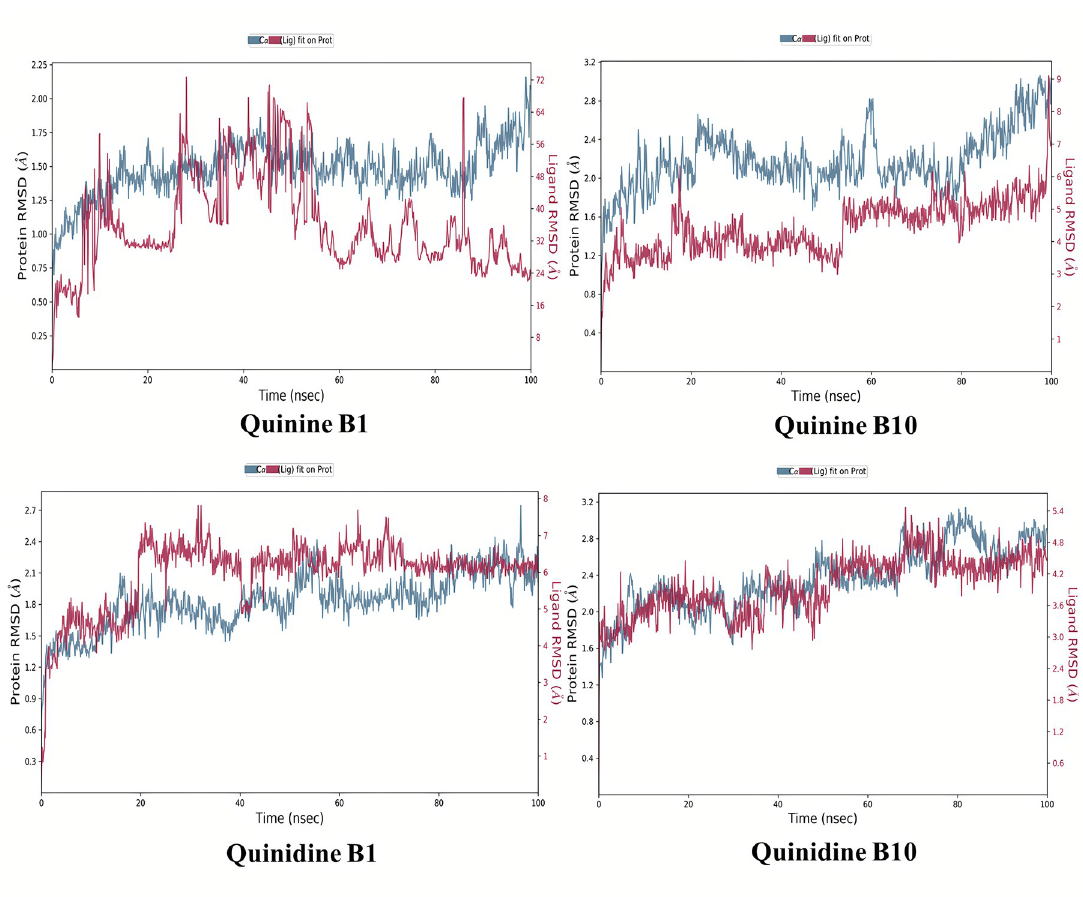
Fig 16. Root mean square deviation (RMSD) of the C-alpha atoms of AKR1B1-Quinine, AKR1B1-Quinidine; AKR1B10-Quinine, AKR1B10-Quinidine complexes with time. The left Y-axis shows the variation of protein RMSD through time. The right Y-axis shows the variation of ligand RMSD through